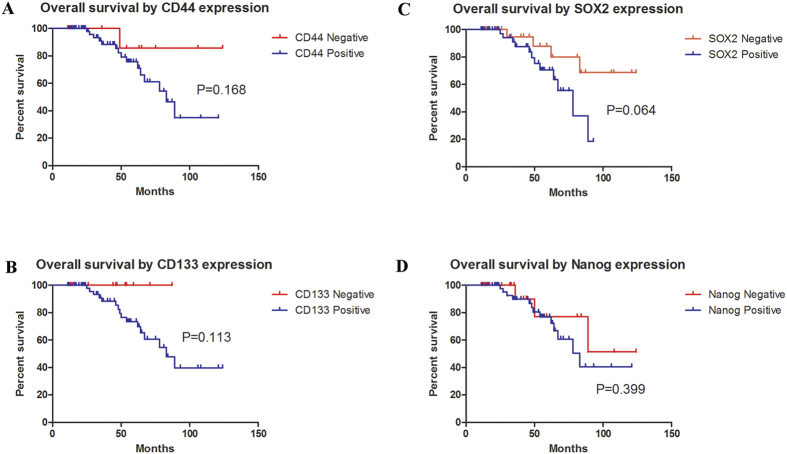
Kaplan–Meier curves estimated by the expression of CD44 (A), CD133 (B), SOX2 (C) and Nanog (D).